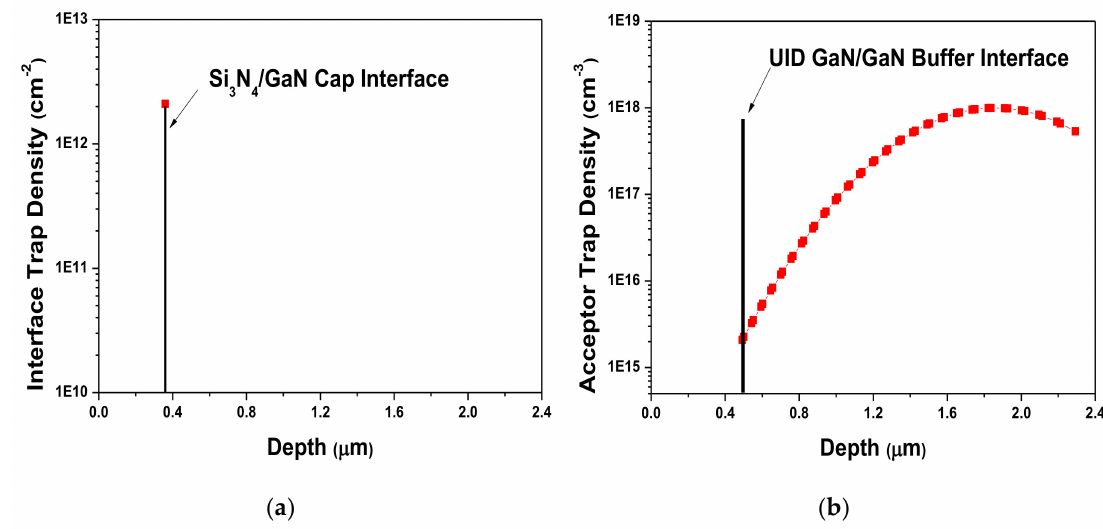
Figure 3. ( a ) Interface trap density at the Si 3 N 4 / GaN cap interface, and ( b ) GaN bu ff er layer acceptor trap density doping profile with respect to